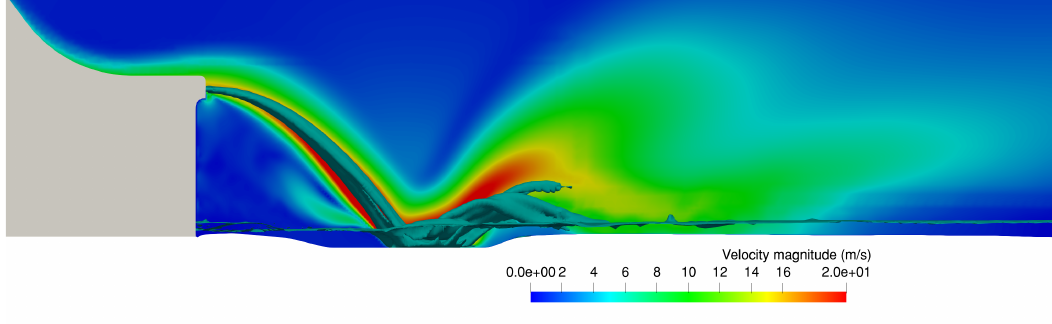
Figure 13. Structure and velocity field of the jet developing from the spillway and impinging on the dissipation basin without the secondary dam at discharge flow rate 300 m 3